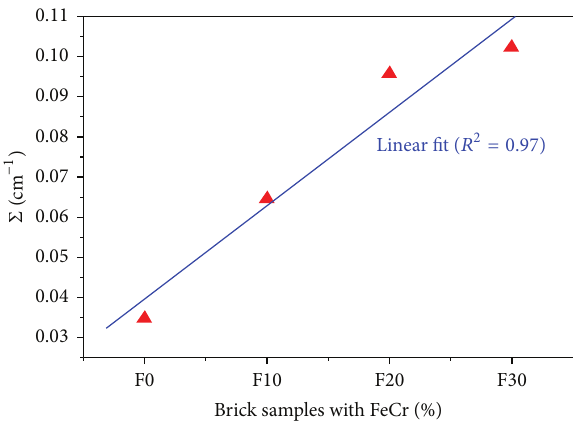
Figure 4: 4.5 MeV neutron macroscopic cross sections of bricks as a function of FeCr slag